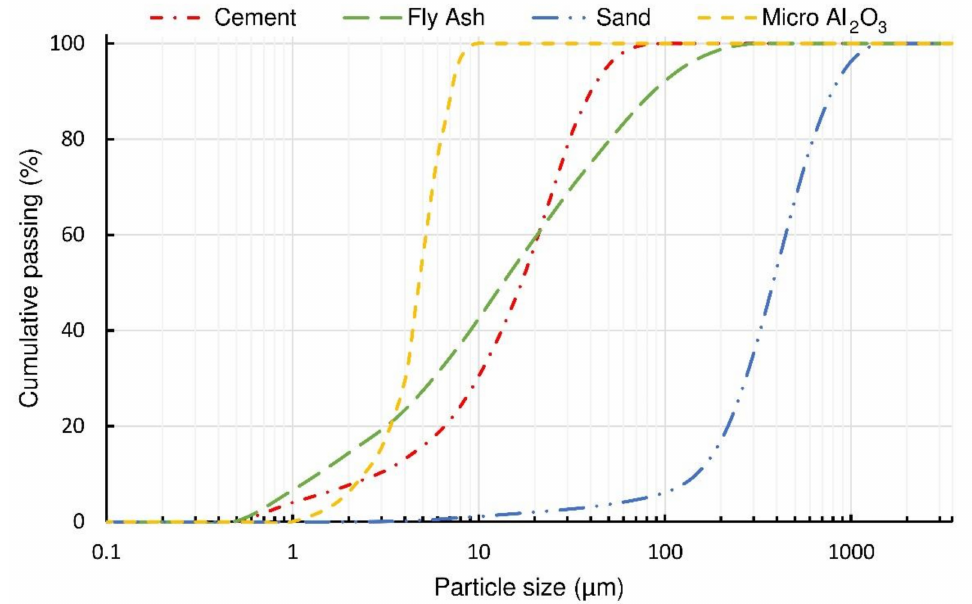
Figure 2. Cumulative particle size distribution for cement, fly ash, fine aggregate and micro-Al 2 O 3